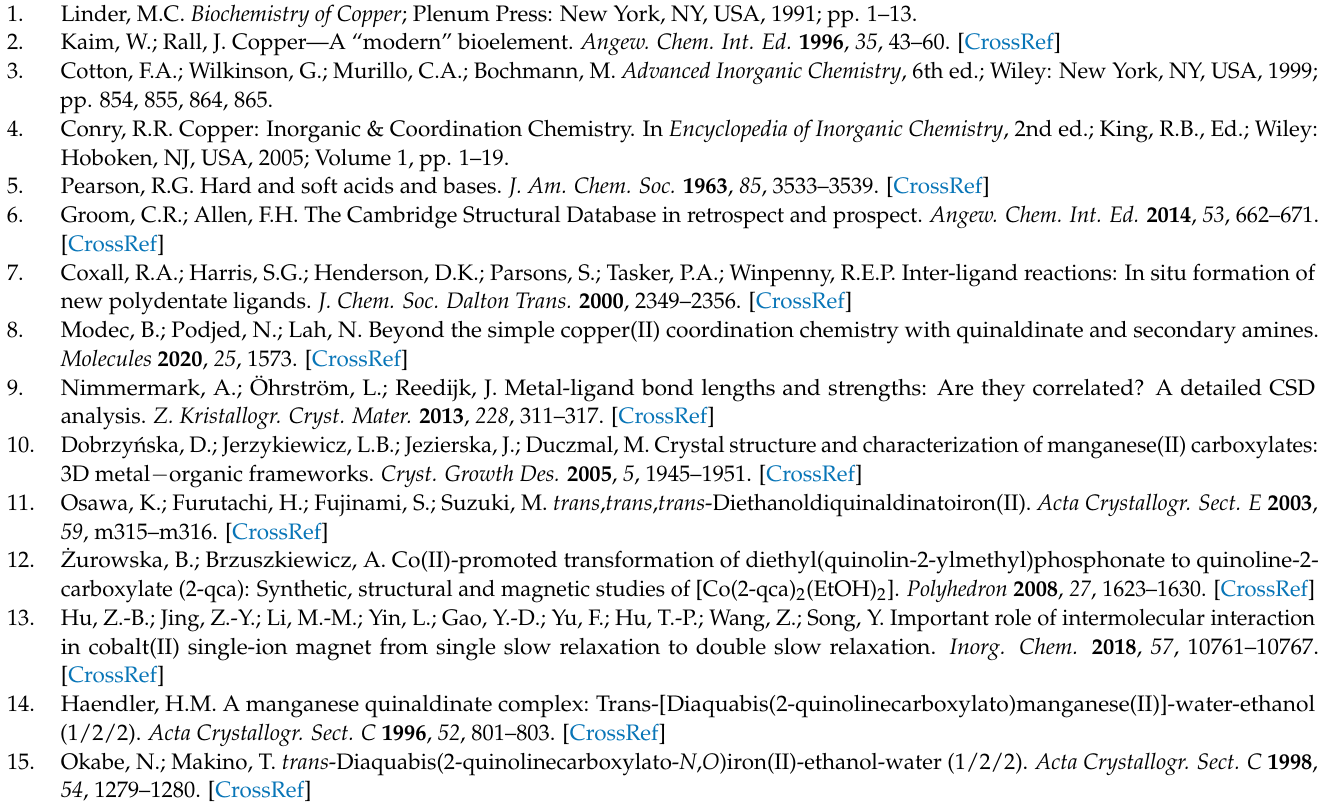
Supplementary Materials: The following are available online, Figure S1: IR spectrum of 1 , Figure S2: TG-MS diagram of 1